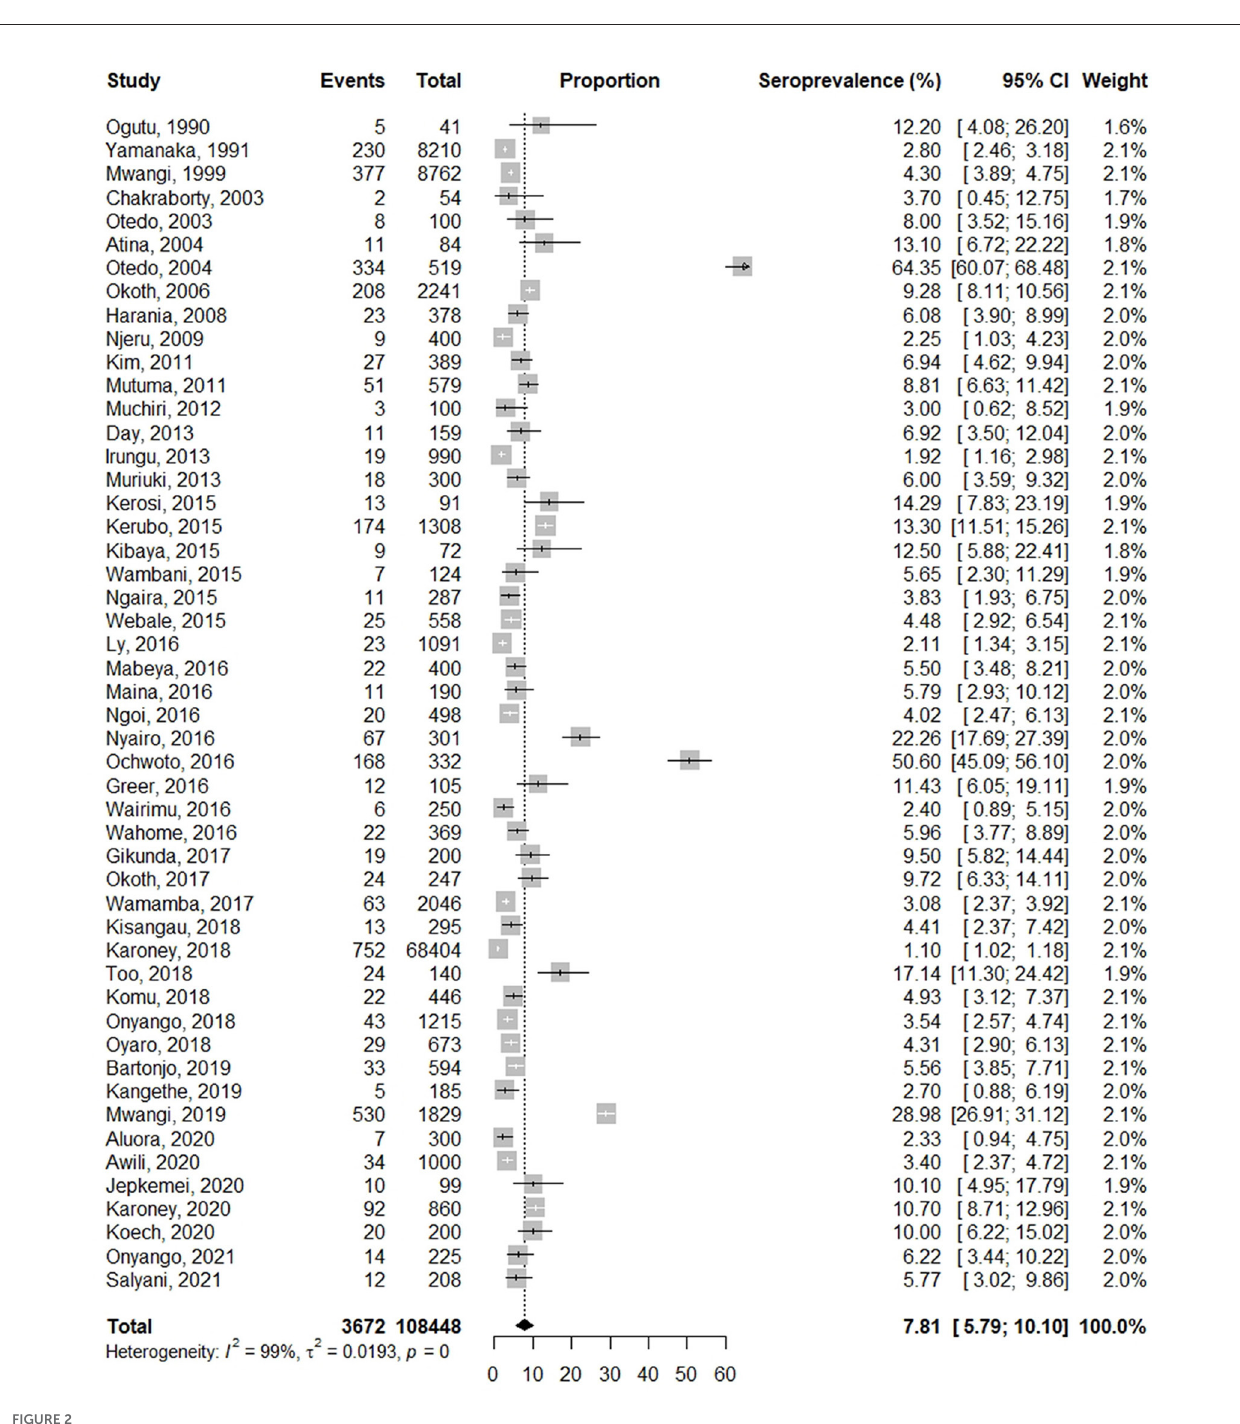
CI: 7.3–20.0), whereas those with a score of ≥ 6 had a prevalence of 7.4% (95% CI: